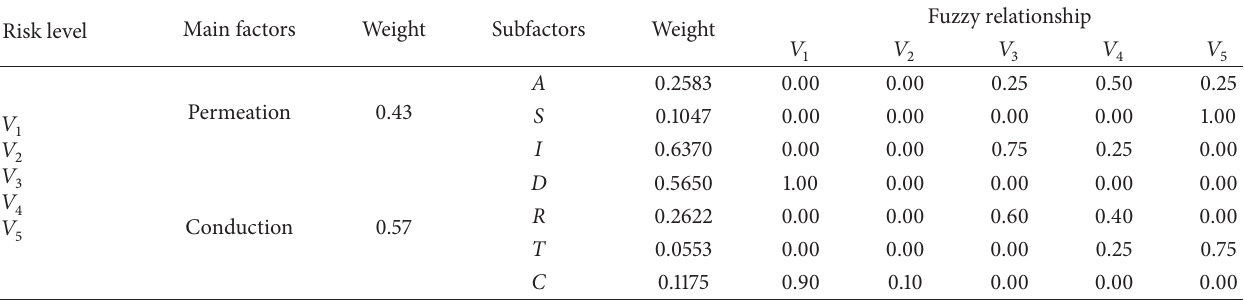
Table 11: Priority weights in AHP system and membership degrees in fuzzy system.